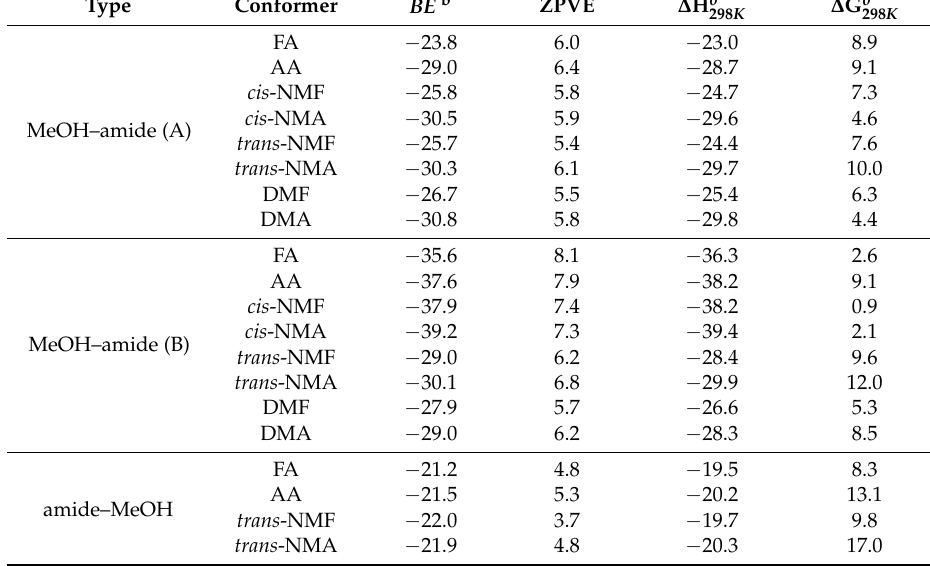
Table 2. Calculated binding energy ( BE ), zero-point vibrational energy (ZPVE), enthalpy of formation ( ∆ H θ ), Gibbs free energy of formation ( ∆ G θ 298 K amide–MeOH complexes a . Type Conformer